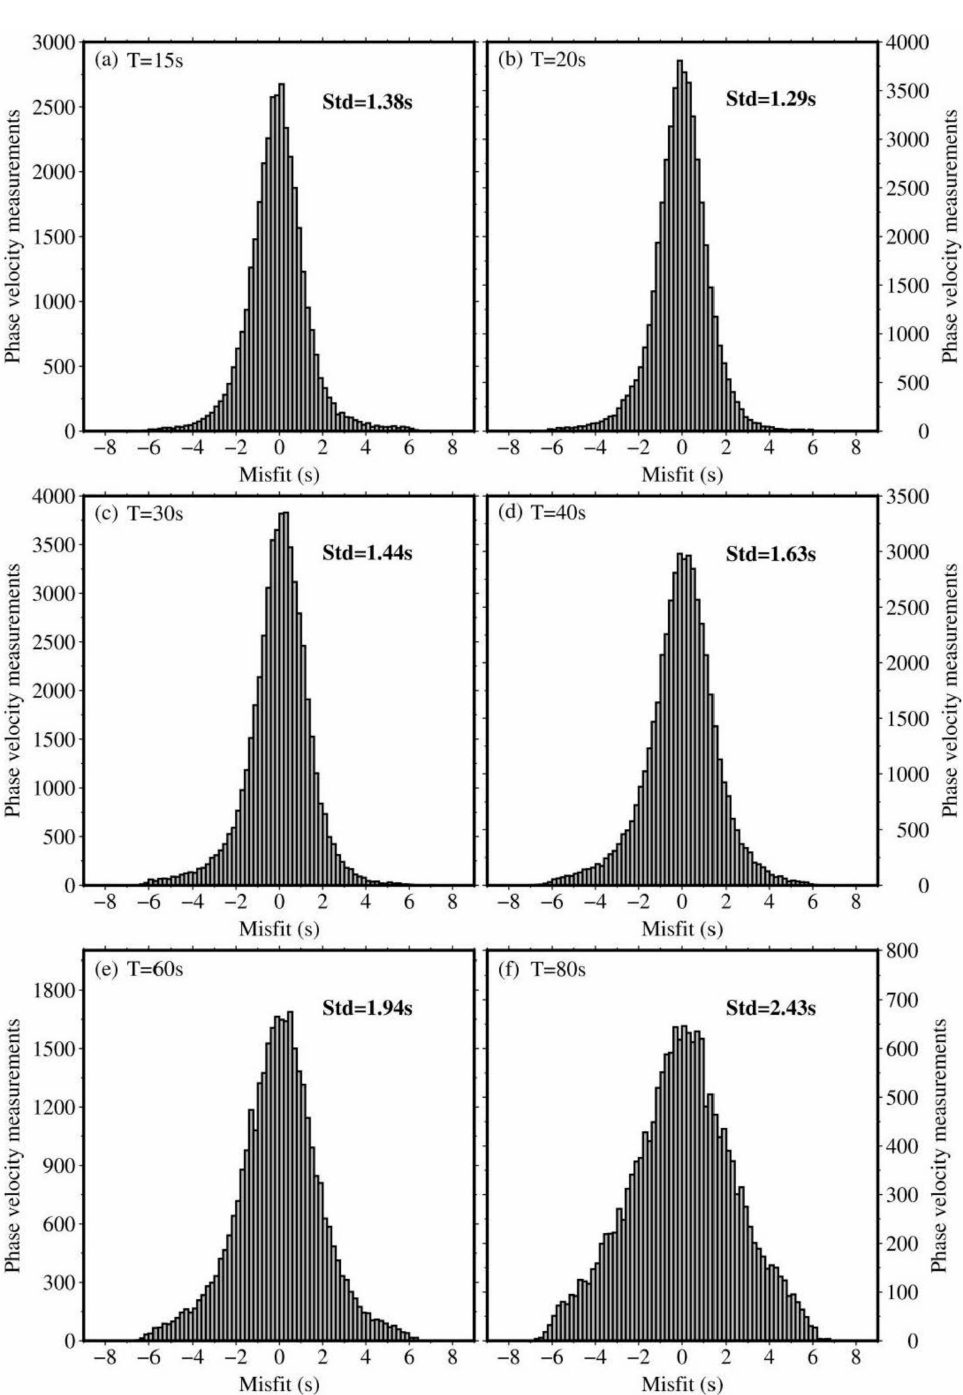
Figure 4. The misfit histograms for the final data set of Rayleigh wave phase velocity at periods of ( a ) 15, ( b ) 20, ( c ) 30, ( d ) 40, ( e ) 60 and ( f ) 80 s, respectively. The standard deviation (Std) of each misfit distribution is estimated in each